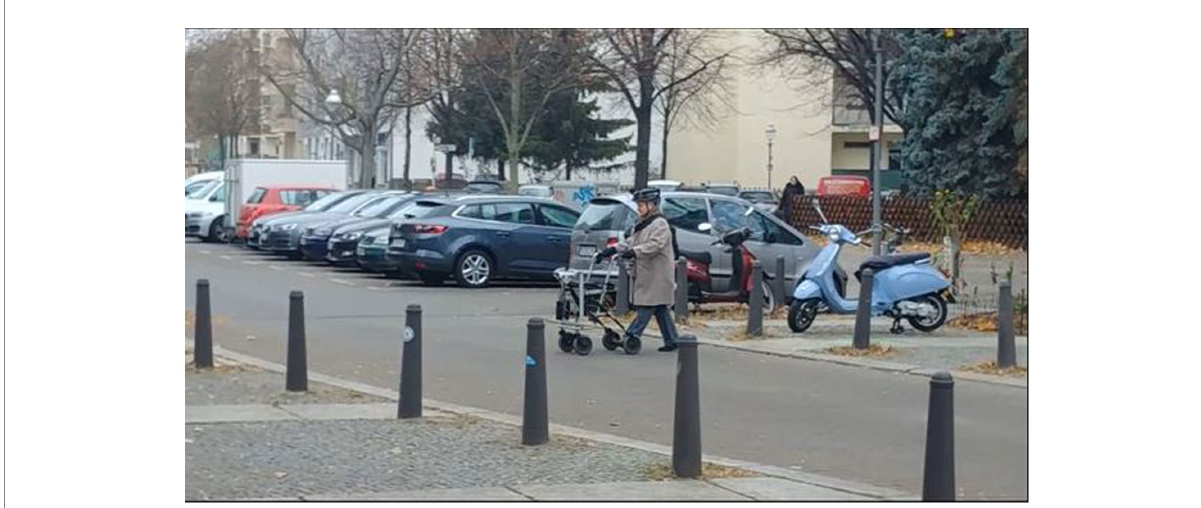
FIGURE 7 Participant in the field study using the walker with the assistance system at a marked crossing.